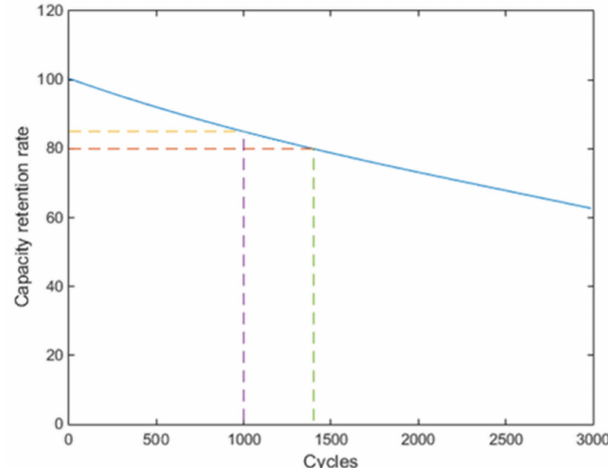
Figure 6. The relationship between the number of cycles and capacity retention rate.